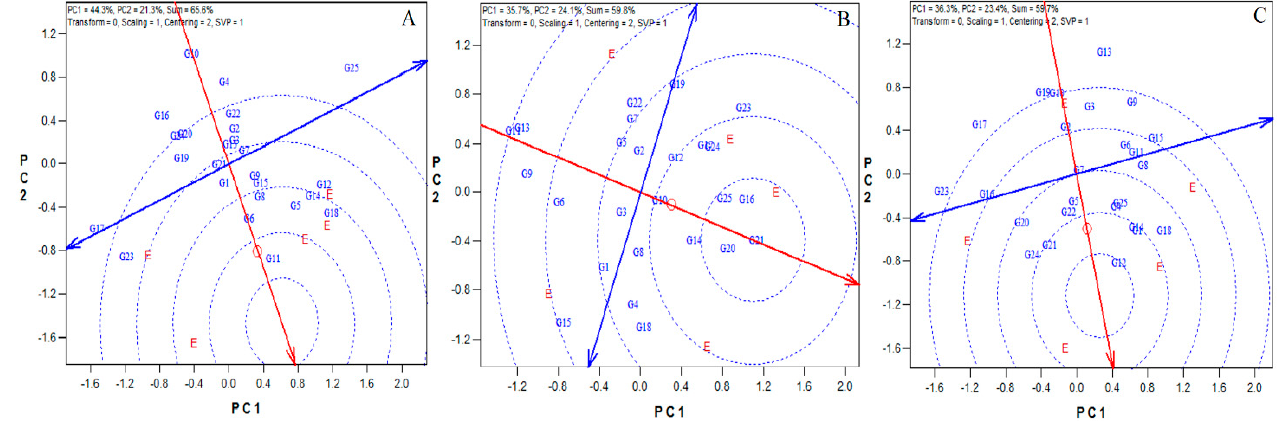
Figure 4. Ranking biplot for comparison of the genotypes with the ideal genotype. ( A ): First year, ( B ): Second year, ( C ): Average of two years. G1:, G2:, G3:, G4:, G5:, G6:, G7:, G8:, G9:, G10:, G11:,